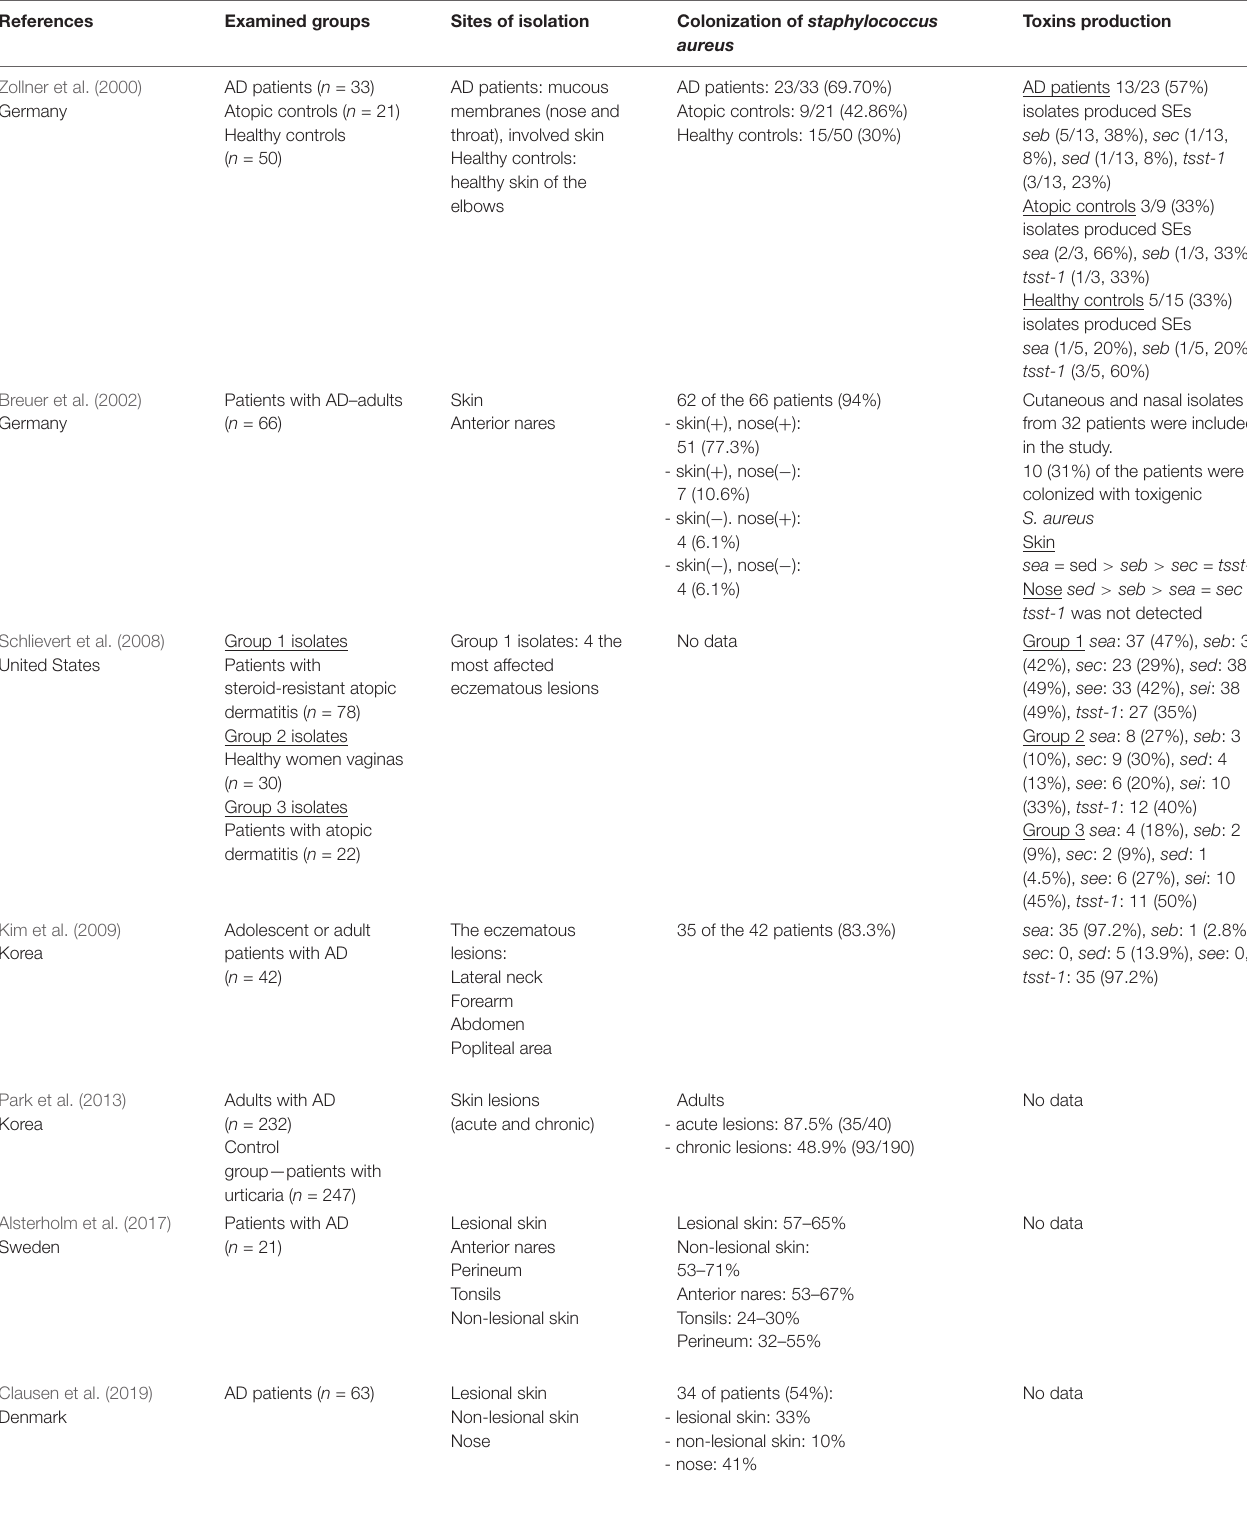
TABLE 2 | The distribution of S. aureus colonization and toxins production in adults with atopic